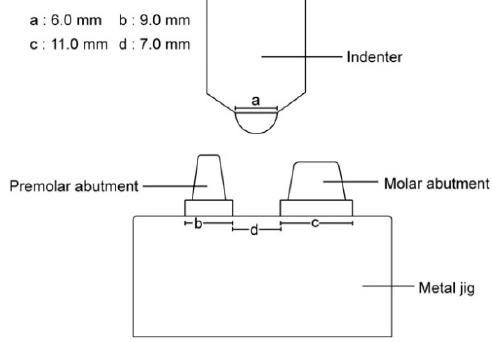
Figure 1. Schematic diagram of metal jig and indenter.